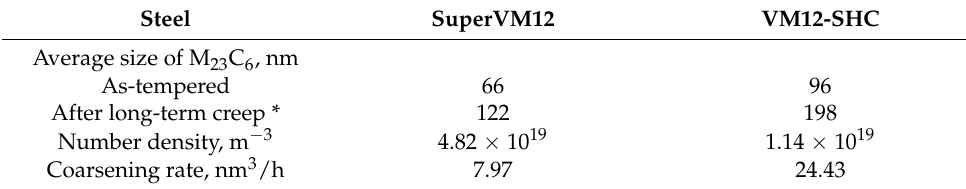
Table 4. Parameters of M 23 C 6 carbides in the SuperVM12 and VM12-SHC steels. Data from